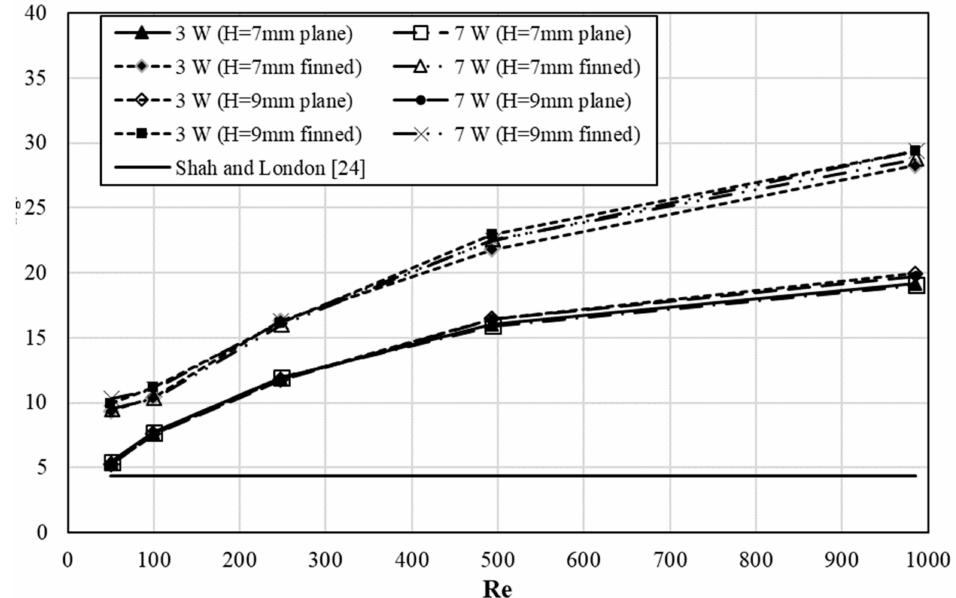
Figure 13. Comparison of the average Nusselt number versus Reynolds